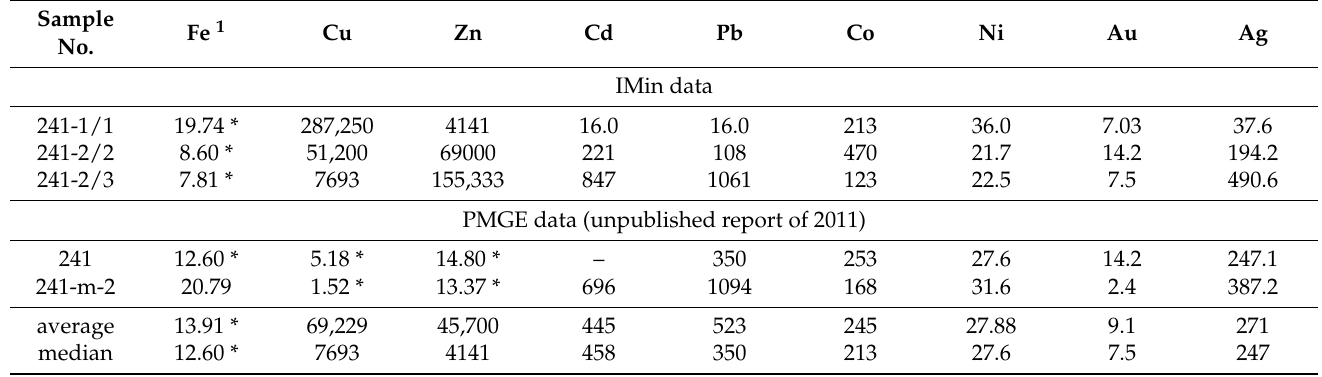
Table 8. AAA-based contents of chemical elements of Zn-rich smoker chimneys from the Irinovskoe HSF (ppm).